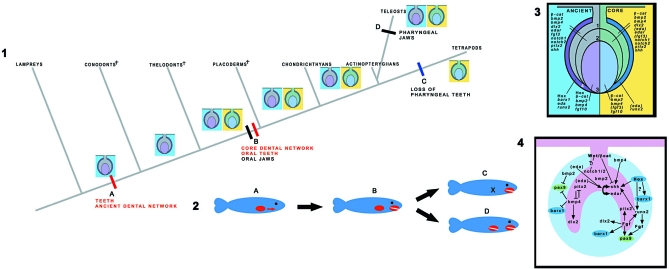
The Coevolutionary History of Jaws and DentitionsPanels 1 and 2 show a simplified evolutionary progression showing the hypothetical advent of the vertebrate ancient gene network (blue icon), core dental network (yellow icon), dentitions, and jaws.Point A indicates the origin of the ancient dental gene network and pharyngeal teeth in extinct (†) jawless fish.Point B indicates the origin of oral jaws in concert with the co-option of the core dental gene network allowing the development of teeth on the recently acquired oral jaws. This was accompanied by the loss of some genes occupying the ancient gene network, including the hox genes and barx1 (Barx1 was then regained in mammalian molar formation); Placoderms (the earliest jawed vertebrates) evolved an oral dentition independently in derived groups [74]; however, we suggest that the networks are common for teeth and were in place prior to the advent of oral jaws.Point C: the branch leading to the tetrapods shows a reduction in the sites that are occupied by a dentition and thus the pharyngeal dentition (ancient dental network) is lost (X in panel 2C). In addition to this loss, the oral dentition is greatly modified in tetrapods. Some vertebrates have lost the entire oral dentition (birds, turtles, etc.), and some have extreme modifications of the oral dentition (e.g., mammals).Point D: advanced groups of teleost fish, including the cichlids, have evolved a modified set of toothed pharyngeal jaws, further co-opting the ancient site of the first teeth and ancient dental gene network for involvement on a new functional jaw.Panel 2: schematic representation of the evolution of teeth and jaws in vertebrates.Panel 3: a schematic developing generalized tooth germ showing localization of the genes in the ancient vs. the core dental network (1, outer dental epithelium; 2, inner dental epithelium; 3, dental papillary mesenchyme; and 4, dental mesenchymal envelope). Color scheme is then represented on panel 1. Bracketed genes represent those with different cellular localization (mesenchyme or epithelium) in alternative vertebrates. Teleosts express fgf3 in the dental epithelium, whereas mammalian Fgf3 is mesenchymal; teleosts express eda in the mesenchyme, whereas mammalian Eda is epithelial.Panel 4: schematic representation of a generalized vertebrate tooth germ showing the putative interactions between the dental epithelial (pink) and dental mesenchymal (light blue) genetic players of the core dental network; those genes in blue ovals represent elements of the ancient dental network (e.g., Hox and barx1); those in green (pax9) represent molecules of neither the core nor the ancient dental network, present during oral dentitions of the mouse and cichlids (Table 1). eda is in brackets due to the differential expression between fish (mesenchyme) and mammals (epithelium). Regionalized signaling in an enamel organ such as that originating from the enamel knot has been purposely omitted from this generalized diagram. See Table S2 for references documenting each interaction.